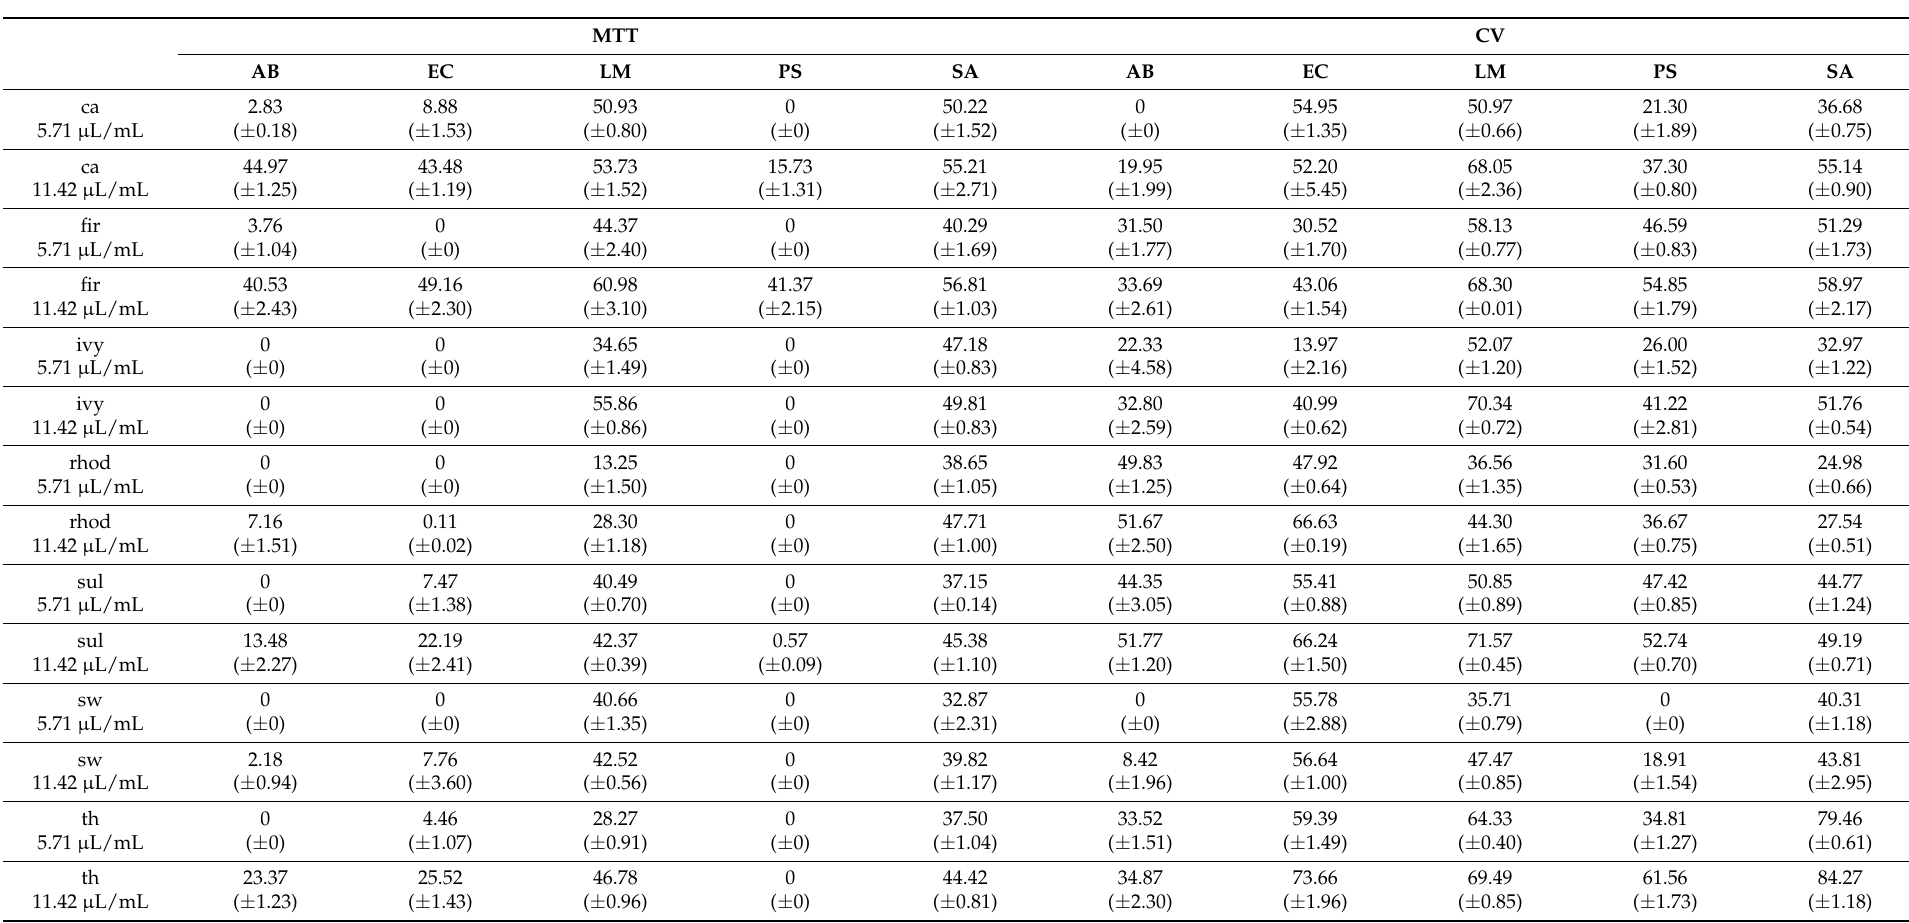
Table 4. Inhibitory activity of the monofloral honeys, tested at 5.71 µ L/mL and 11.42 µ L/mL, on the adhesive capacity by five pathogenic bacteria. Results are expressed as percentage (average ± SD) and calculated assuming for the control (untreated bacteria) an inhibition value = zero. Legend: ca: cardoon honey; fir: fir honey; ivy: ivy honey; rhod: rhododendron honey; sul: sulla honey; sw: strawberry tree honey; th: tree of heaven honey. AB: A. baumannii ; EC: E. coli ; LM: L. monocytogenes ; PS: P. aeruginosa ; SA: S. aureus. MTT: data of the inhibitory action exhibited by the honey on bacterial metabolism, evaluated through the MTT test; CV: data of the inhibitory action exhibited by the honeys on the biofilm, evaluated through the Cristal violet